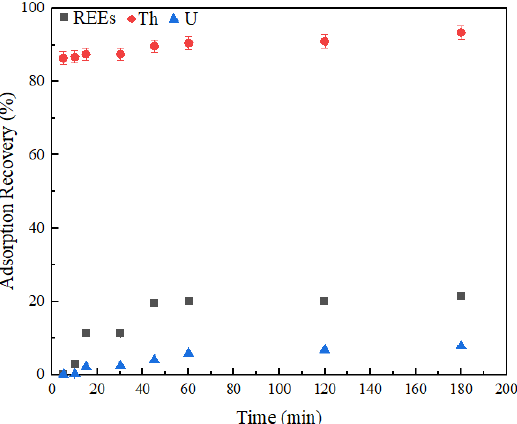
Figure 10. Adsorption recoveries of total rare earths, thorium, and uranium as a function of contact time. Error bars represent one standard deviation of multiple replicate tests.